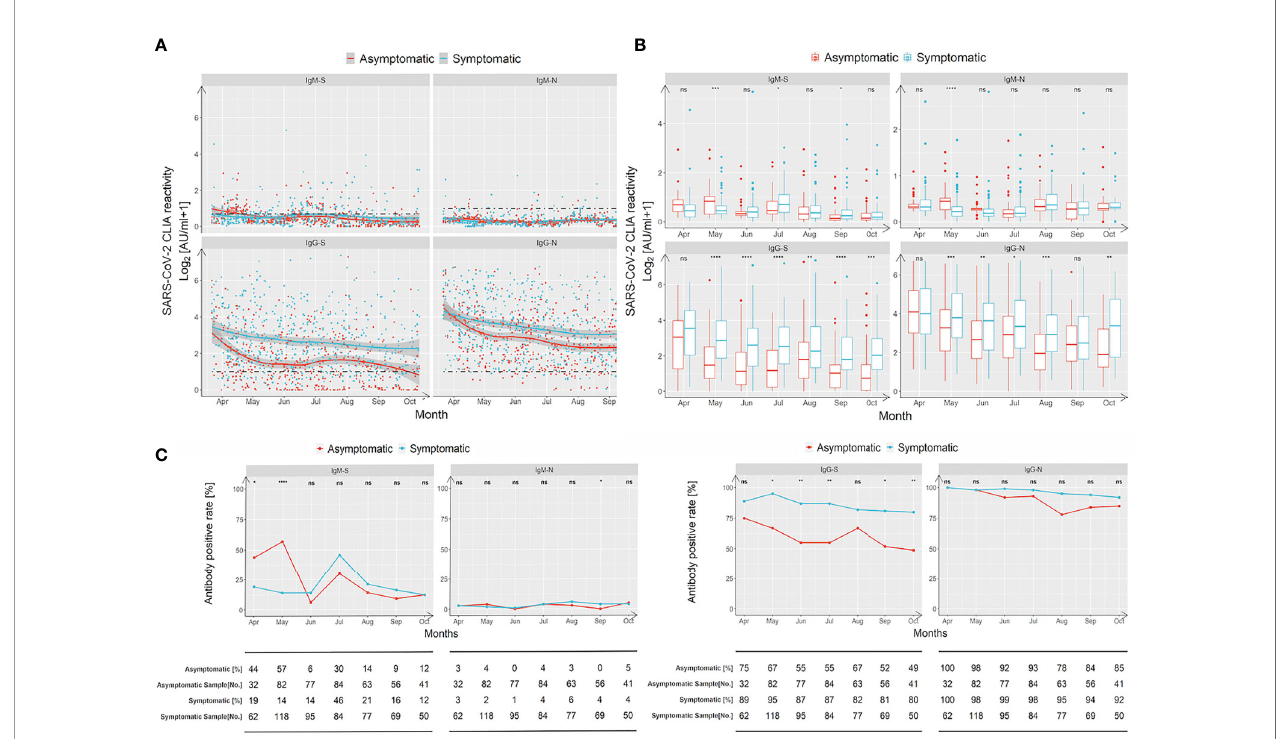
FIGURE 2 | In absence of antigen re-exposure, asymptomatic individuals lose SARS-CoV-2-speci fi c IgG-S responses more rapidly than symptomatic patients do. IgM and IgG recognizing the RBD of the spike protein ( ‘ S ’ ) and the nucleoprotein ( ‘ N ’ ) of SARS-CoV-2 were quanti fi ed by capture chemi-luminescence immunoassays (CLIA) for 29,177 samples obtained from 25,091 patients. (A, B) Plasma antibody levels of IgM-S, IgM-N, IgG-S, and IgG-N in samples obtained from asymptomatic (red) and symptomatic (blue) patients obtained during April 2020 and October 2020 are presented. The line shows the mean value calculated using a Lowess regression model and the shaded area represents the 95% con fi dence interval. The boxes in (B) show medians (middle line), 75% quartiles (upper bound) and 25% quartiles (lower bound), and the whiskers show 1.5-fold the IQR above and below the box. Repeated measures (mixed model) ANOVA was used for statistical analysis. ns, no signi fi cance, *p < 0.05; **p < 0.01; ***p < 0.001, ****p < 0.0001, two-sided. (C) Antibody positivity rates of asymptomatic (red) and symptomatic (blue) groups tested at indicated months after the epidemic ended are shown. The table below the fi gure depicts the numbers of assessed patients at indicated time points. Chi-square test was used for statistical analysis. ns, no signi fi cance, *p < 0.05; **p < 0.01; ***p < 0.001, ****p < 0.0001,